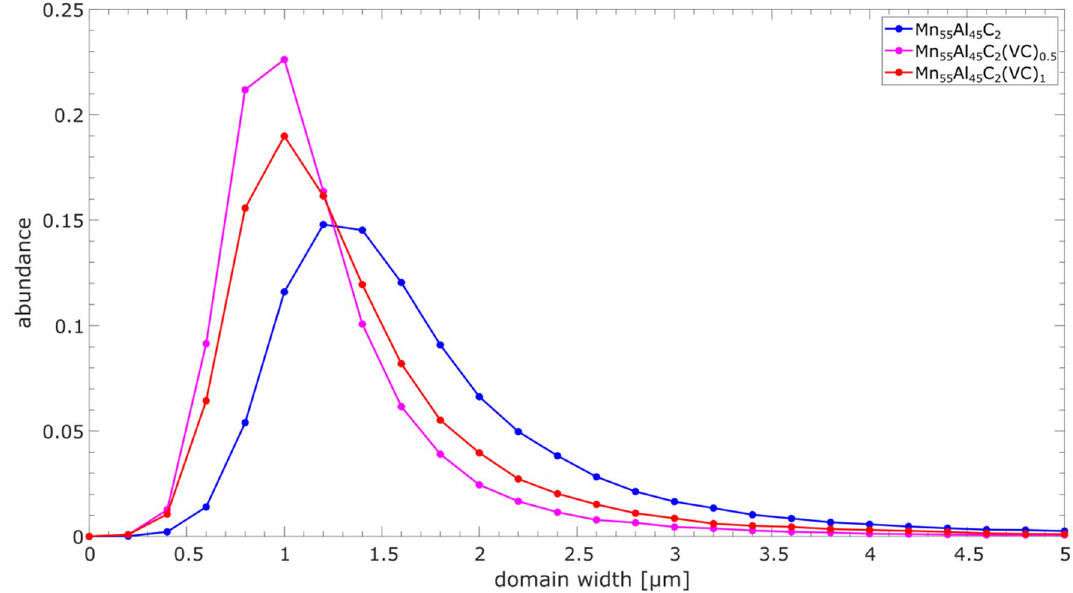
Figure 7. Domain width distributions for Mn 55 Al 45 C 2 , Mn 55 Al 45 C 2 (VC) 0.5 and Mn 55 Al 45 C 2 (VC) 1 . A clear peak shift to lower domain width is visible in both the samples with 0.5% and 1% VC precipitates.